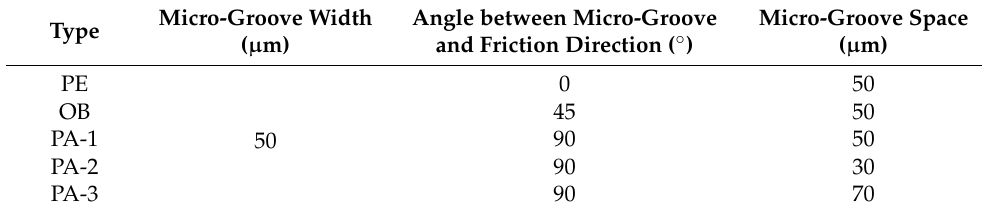
Table 2. The geometric parameters of